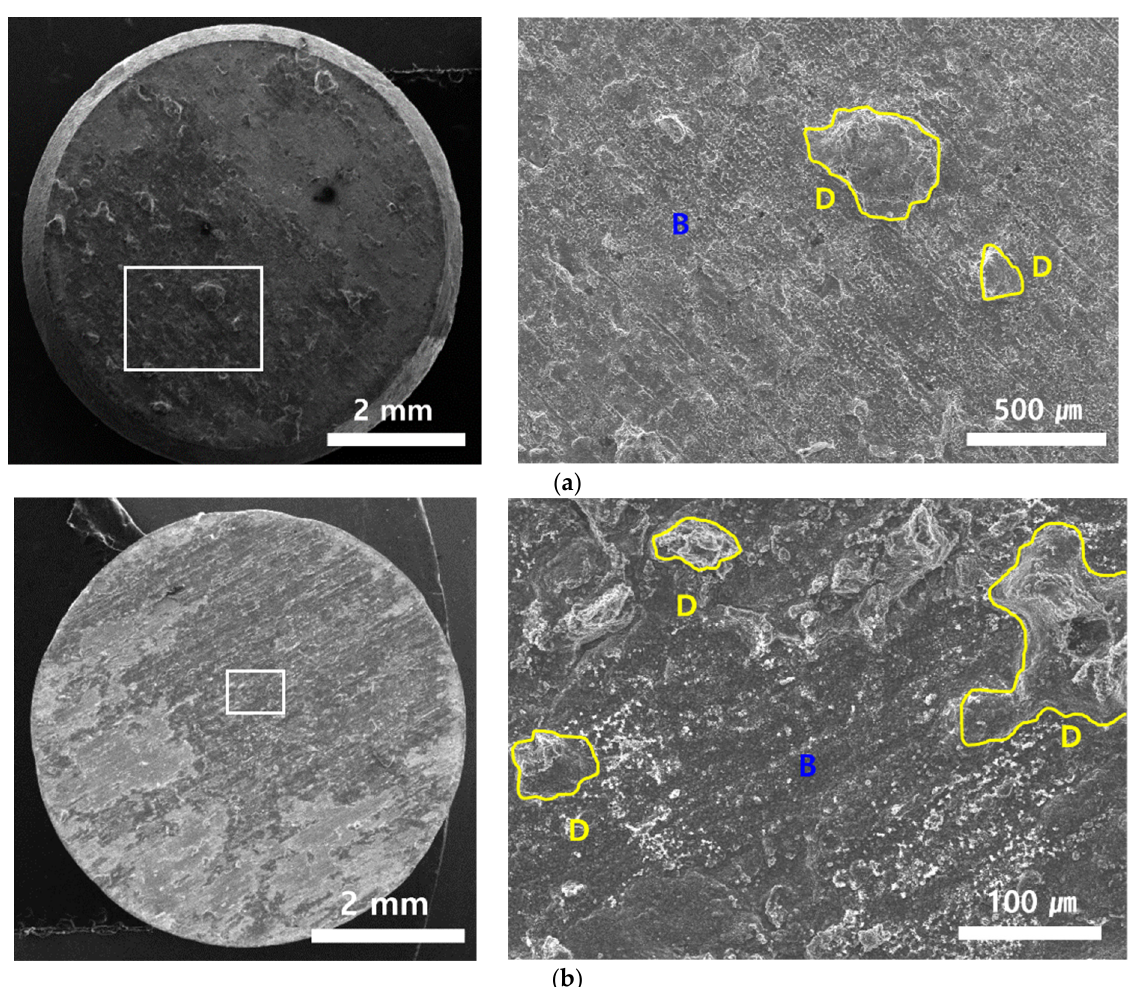
Figure 6. The representative fracture surface of the crept specimens. Stress-rupture tests were conducted at ( a ) 900 °C/25 MPa and ( b ) 900 °C/50 MPa.